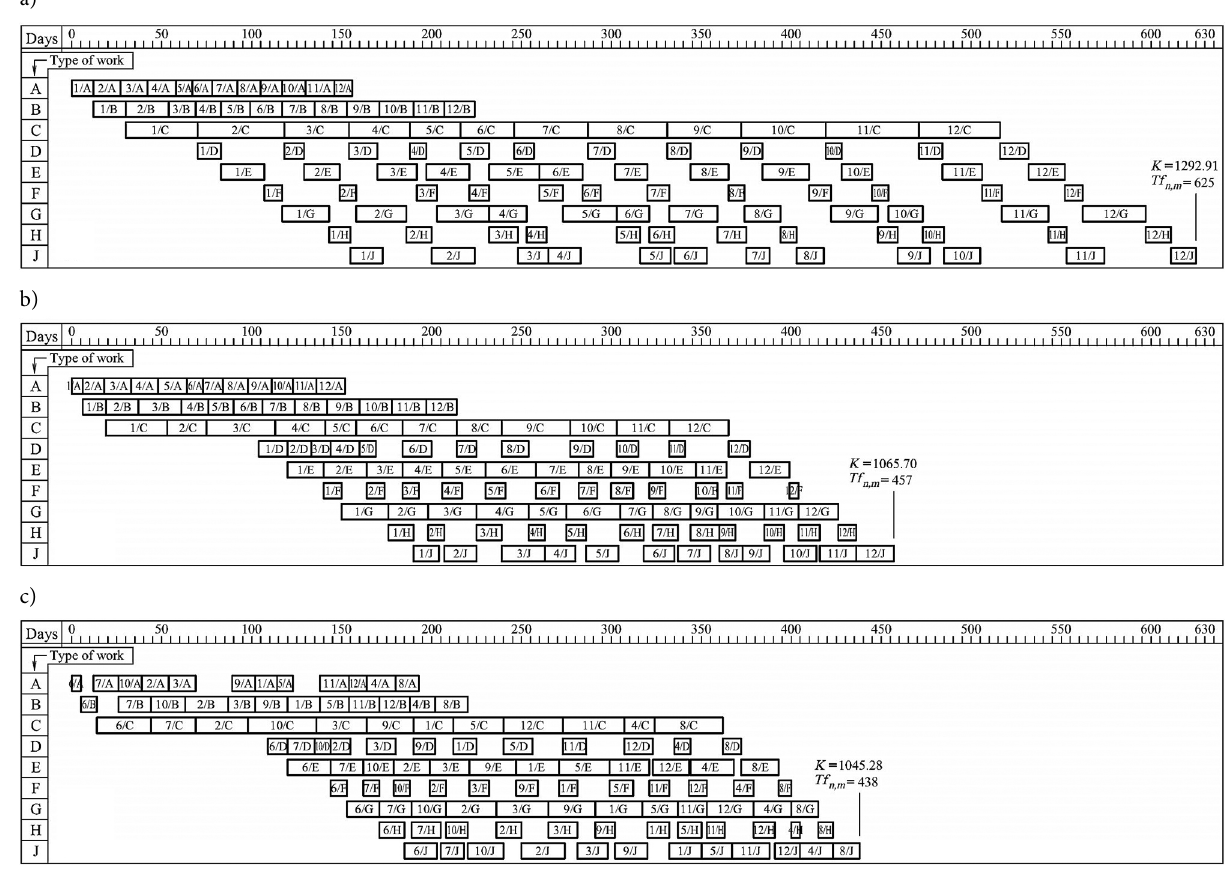
Figure 2. Schedules for the implementation of project in the case study: (a) – for π 0 = (1, 2, 3, 4, 5, 6, 7, 8, 9, 10, 11, 12) without optimization; (b) – for π 0 with optimization; (c) – for π SA = (6, 7, 10, 2, 3, 9, 1, 5, 11, 12, 4, 8) with optimization using SA algorithm